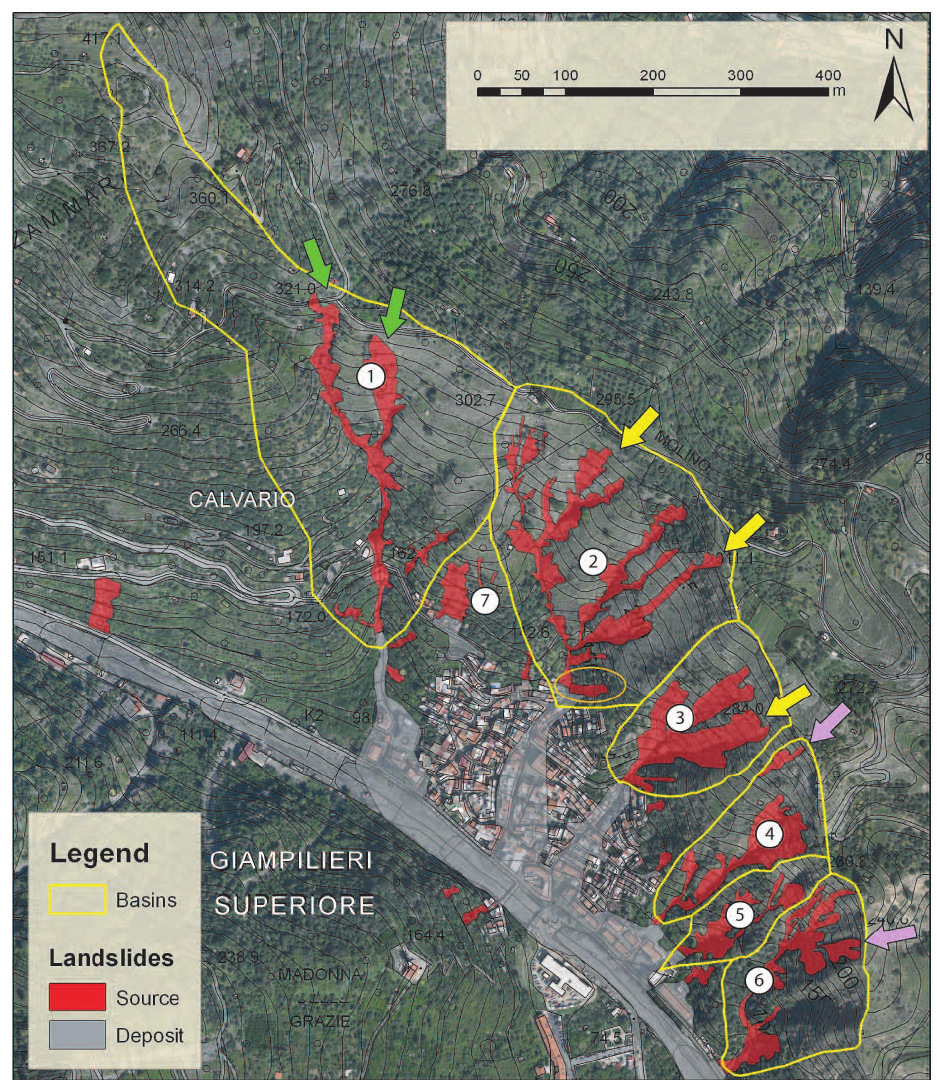
Fig. 6. Post event orthophoto of Giampilieri; the October 1st debris flows are shown in red. Definition of landslide boundaries were obtained from two days post-event orthorectified images. The yellow lines indicate catchment boundaries. Natural and human predisposing factors are also specified: yellow arrows for slope change, green ones for water accumulation related to anthropic activity (roads or agricultural terraces), purple arrows for retrogressive evolution reaching the divide. The light orange ellipse indicates a landslide probably triggered by toe undermining by the main